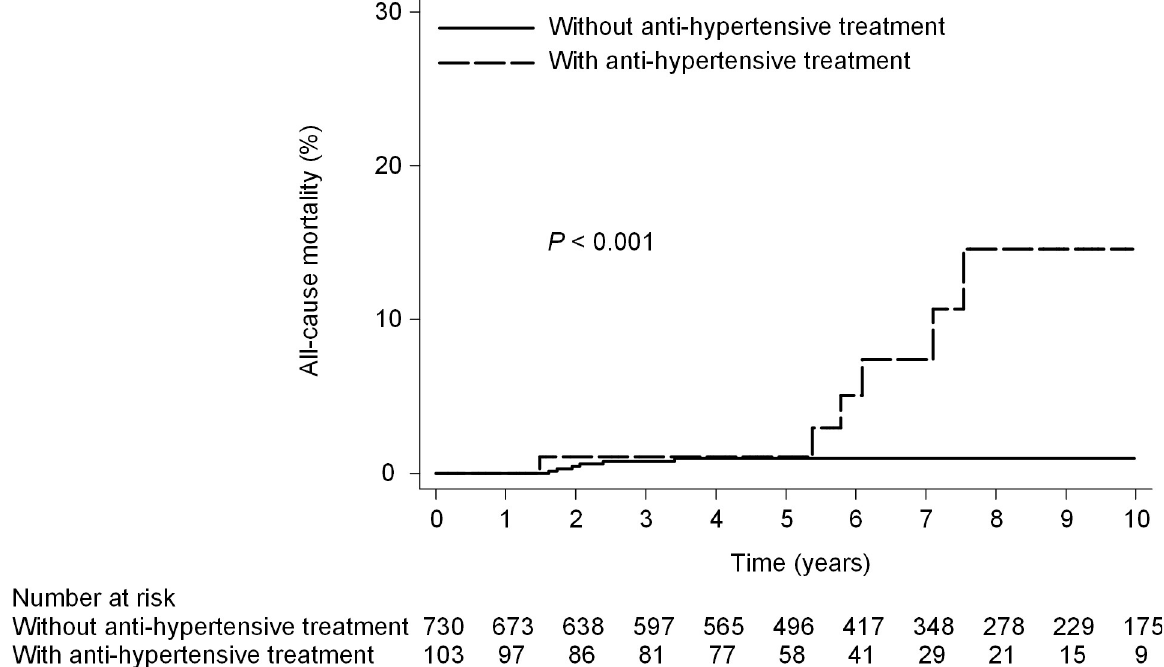
Fig 5. All-cause mortality according to anti-hypertensive treatment. (10- year mortality rate, 1.0% vs 14.6%; HR, 7.2; 95% CI, 2.5–21.3; P <